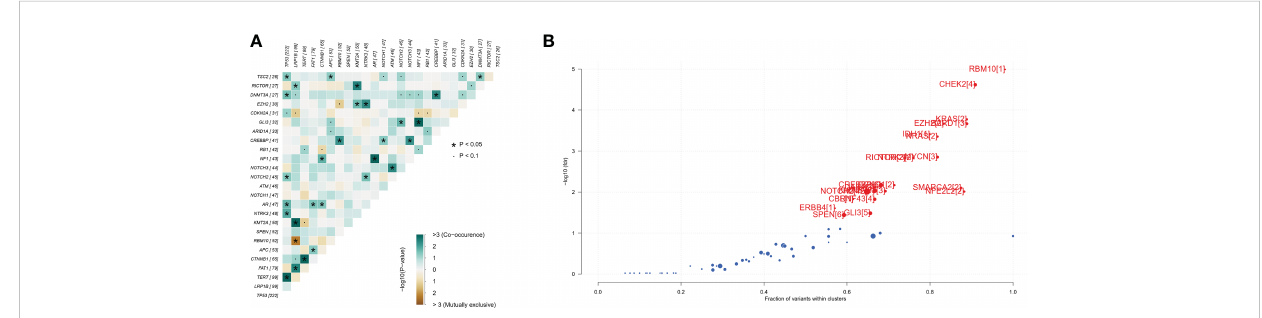
FIGURE 2 Identi fi cation of mutation interactions and cancer driver genes in the Chinese HCC cohort. (A) The co-occurrence or exclusive associations between top 25 mutation genes. (B) Detecting cancer driver genes based on positional clustering in HCC. Each dot represents a gene, and the size of the dot represents the number of clusters (mentioned inside square brackets) within which a fraction (X-axis) of total variants is accumulated. HCC, hepatocellular